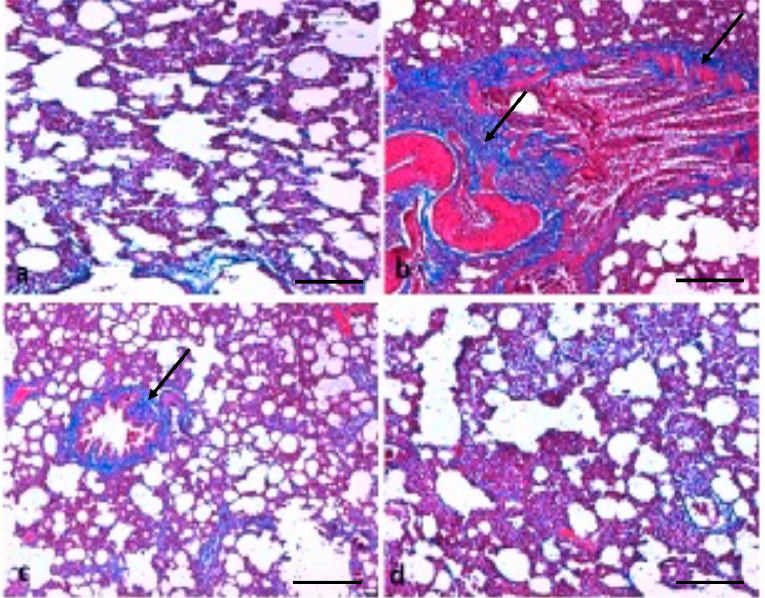
Figure 7. Effect of TQ on lung fibrosis. ( a ) Normal fibre architecture of hepatocyte in control ani- mals; ( b ) B(a)P administration induces severe collagen deposition; the arrow indicates high depo- sition of collagen fibers ( c ) TQ shows suppression of B(a)P-induced fibrosis; the arrow indicates less deposition of collagen fibers. ( d ) normal collagen in the group treated with TQ only. (Scale bar = 100 μ m.)